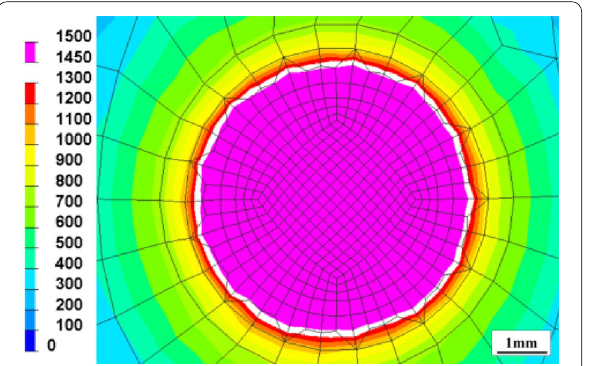
Figure 21 Welding method is the combined surface temperature field of the new 6-sections welding joint